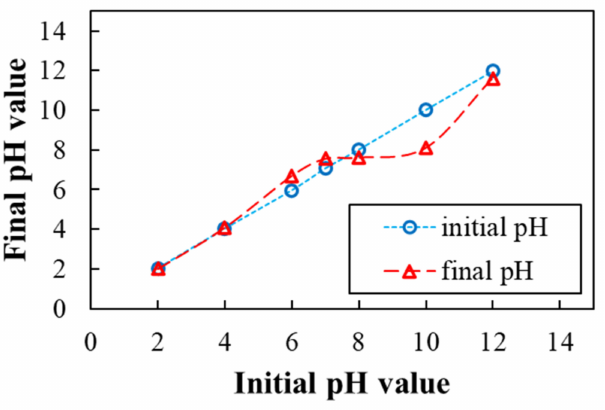
Figure 4. The deliberate mark of zero charges of HNT at the